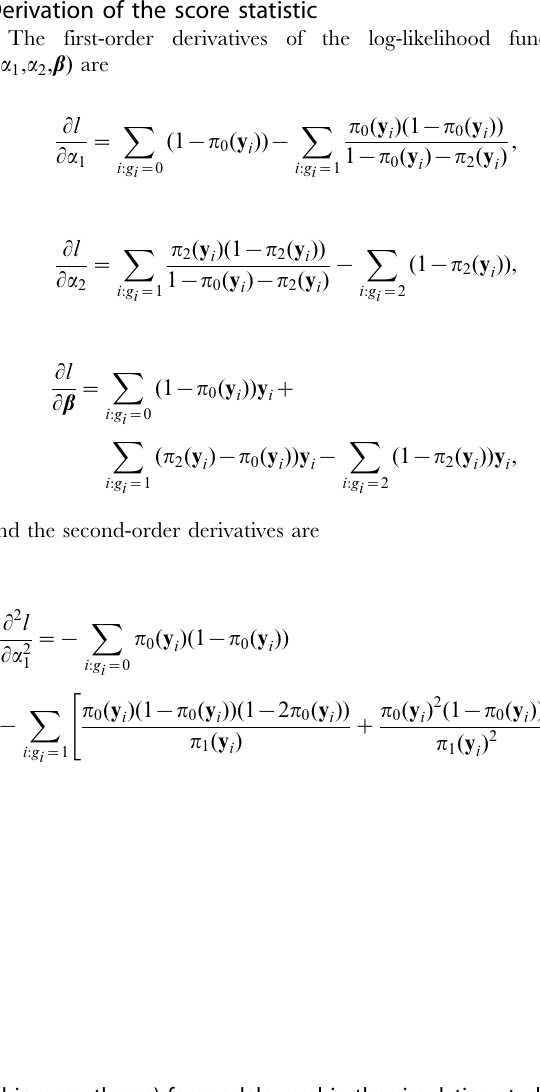
Frequency of Allele a Effect of Allele a Recessive Additive